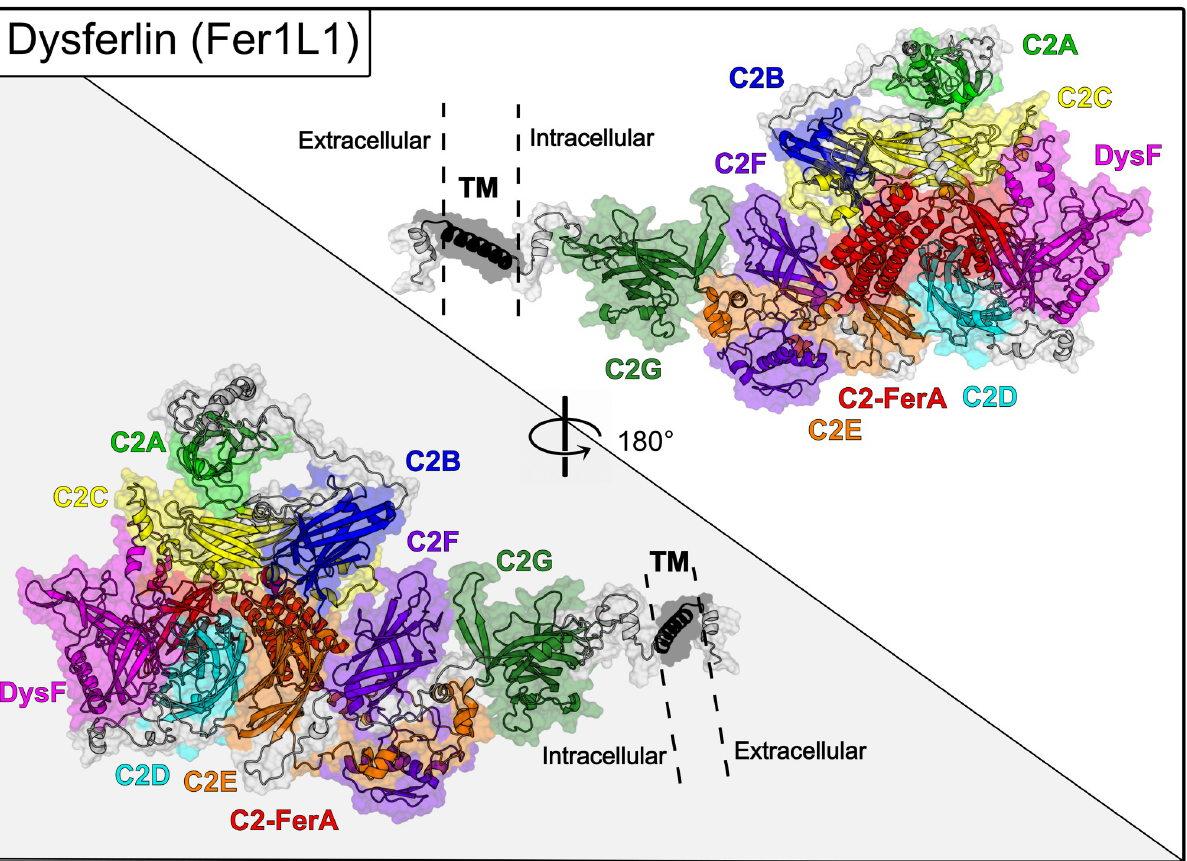
Fig 2. RoseTTAFold model of the full-length dysferlin. The full-length model indicated super-tertiary [53] domain interactions in the dysferlin model. The RoseTTAFold models that were used in this study were flexibly aligned using FATCAT [54]. Inconsistencies in the 3D models that were generated as a result of the elastic alignment process were repaired using PyMod [55]. Figures were rendered with PyMol and displayed as 180˚ views of the model. The various domains of dysferlin are shown as colored surfaces and similarly colored labels. The other ferlin full-length models can be found in the supplemental information (S1-S17 Figs and S1-S7 Tables in S1